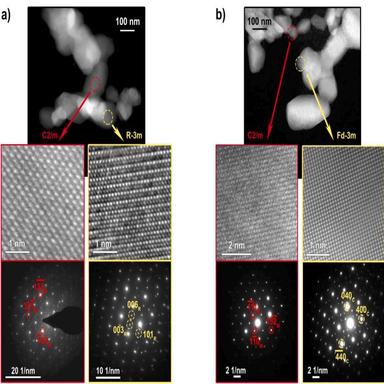
TEM and HAADF-STEM images with the corresponding SAED patterns from selected particles of LiO2 a) charged to 4.8 V and b) discharged to 2.0 V.